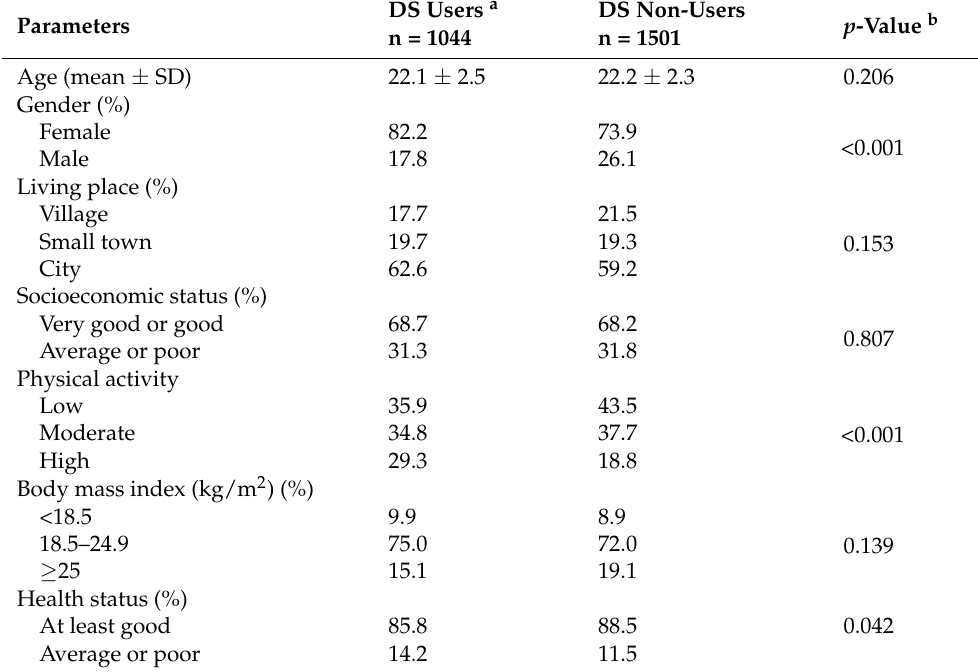
Table 1. Socio-demographic and lifestyle parameters stratified by dietary supplement use in univer- sity students (n =